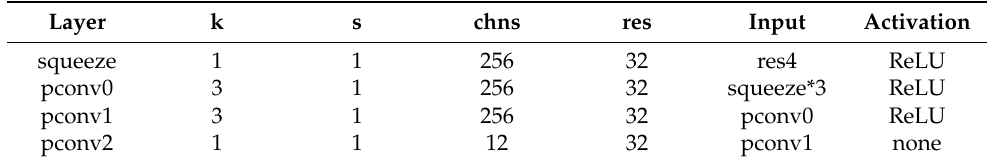
Table 2. Pose decoder network. The ‘squeeze*3’ means that the input layer of pconv0 is the result of concatenating three squeeze layers, which correspond to three consecutive images as the initial input of our